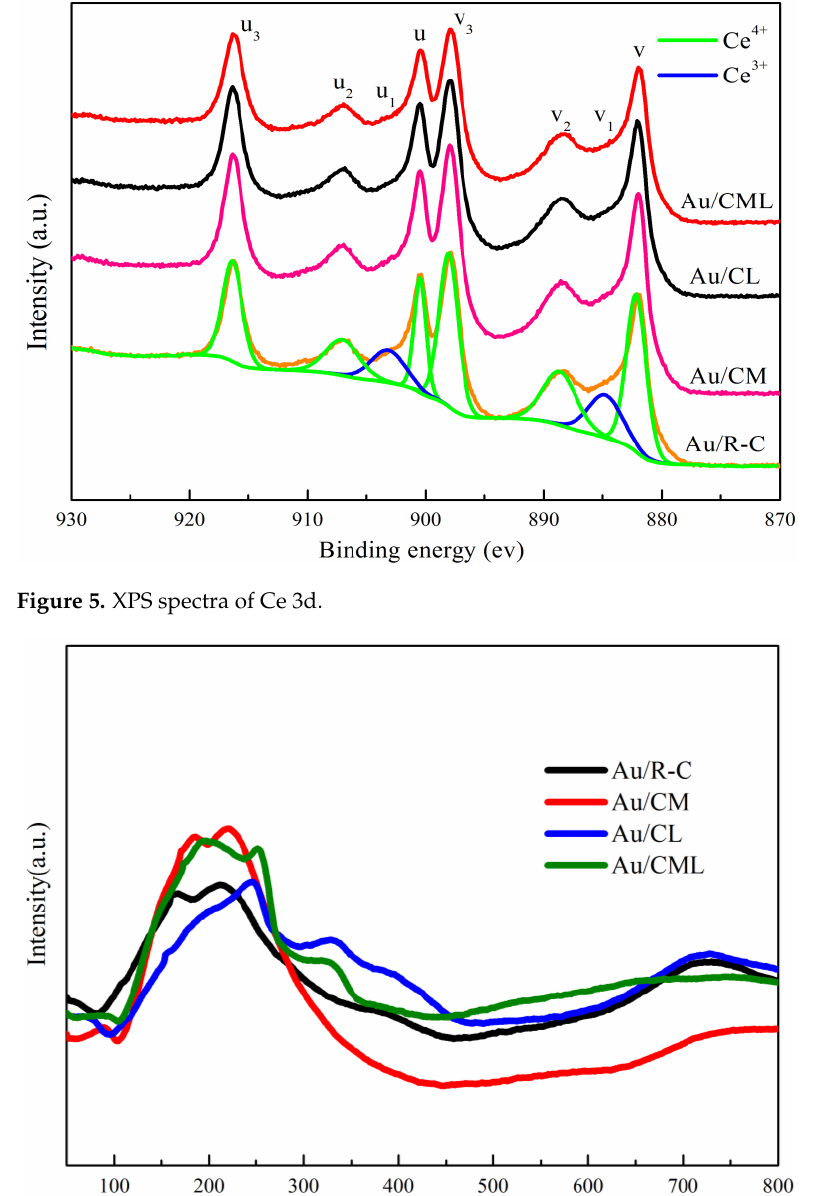
Figure 5. XPS spectra of Ce 3d .